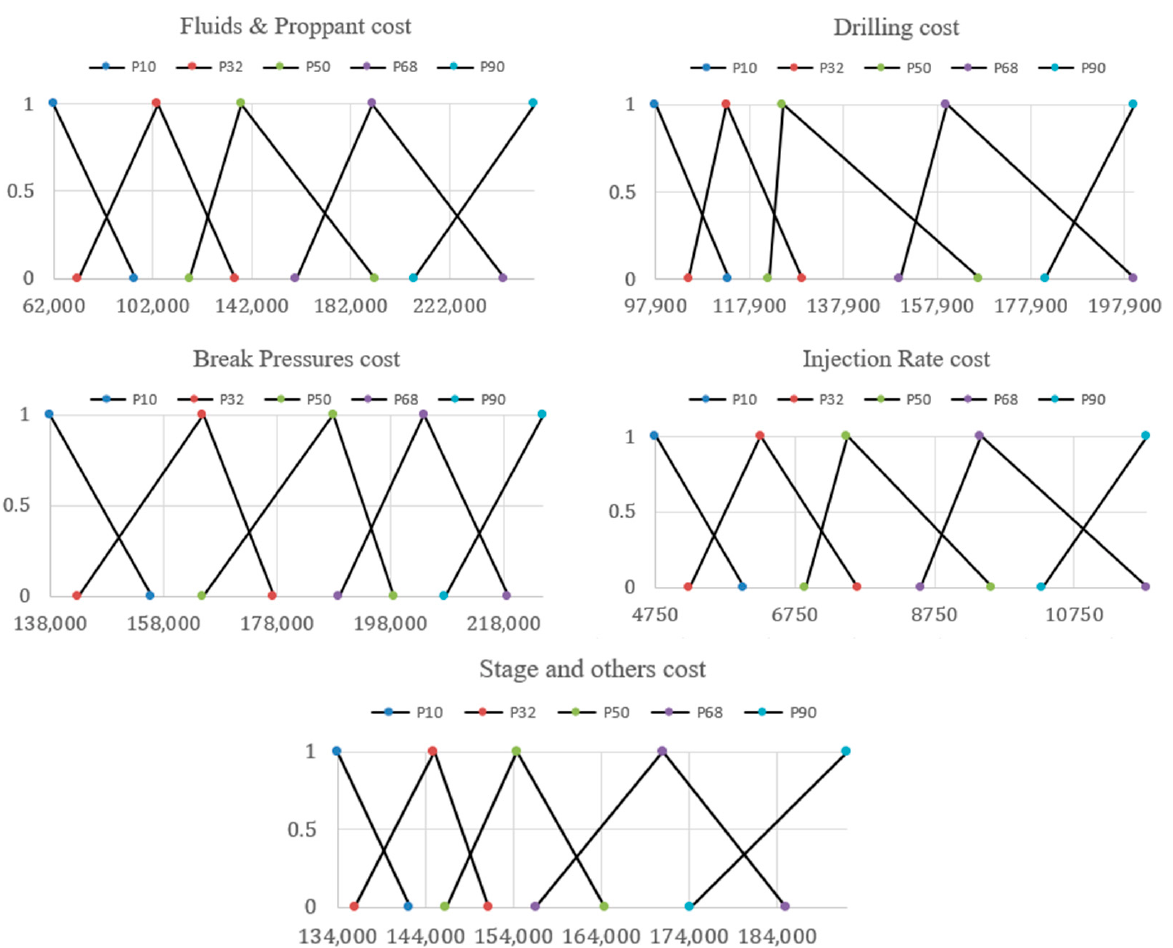
Figure 2. Illustrations of HF cost estimation as output variables (fluid and proppant cost, drilling cost, break pressures cost, injection rate cost, stage and others cost), membership function for each variable (P10: Very Low, P32: Low, P50: Medium, P68: High, P90: Very High).